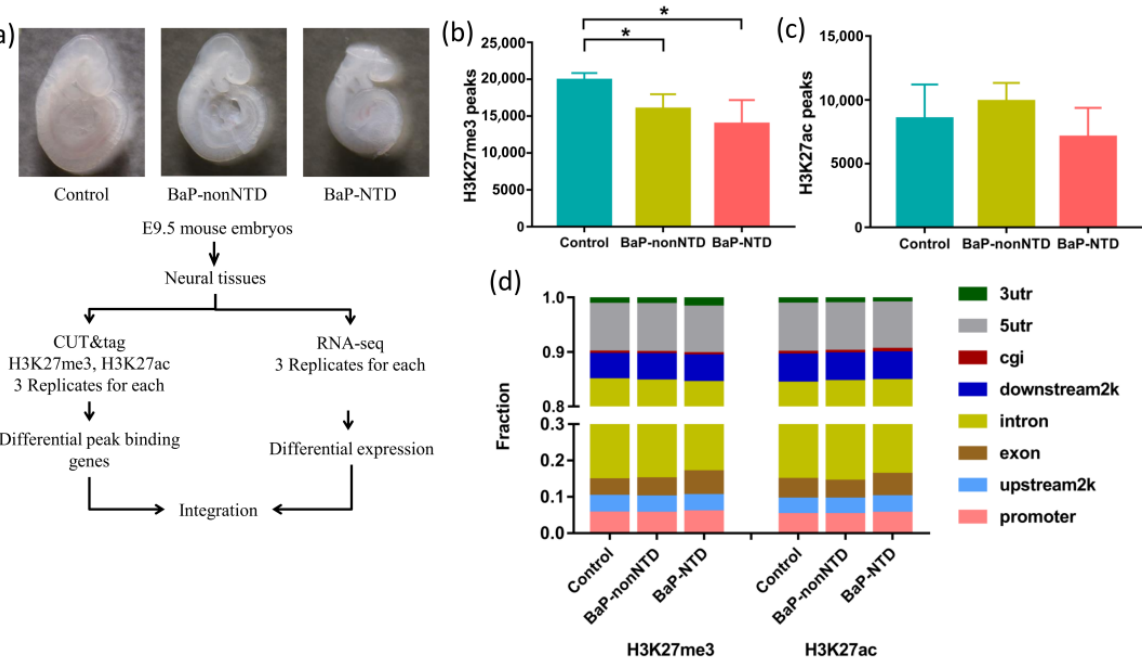
Figure 1. Histone modification profiling of H3K27me3 and H3K27ac in neural tissues from E9.5 normal mouse embryos and NTD embryos. ( a ) Schematic illustration of experimental design. The number of peaks called in different groups for H3K27me3 ( b ) and H3K27ac ( c ). ( d ) The genomic distribution of different histone modification regions in control, BaP-nonNTD and BaP-NTD embryos. * p < 0.05, compared with control group.